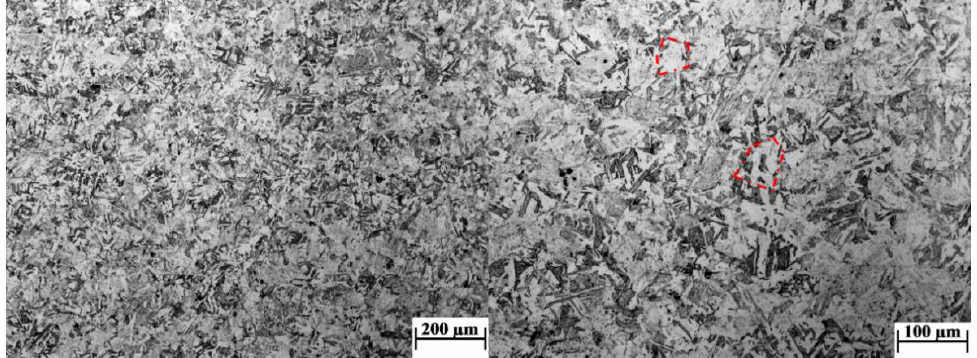
Figure 6. Grain size of single heating process.